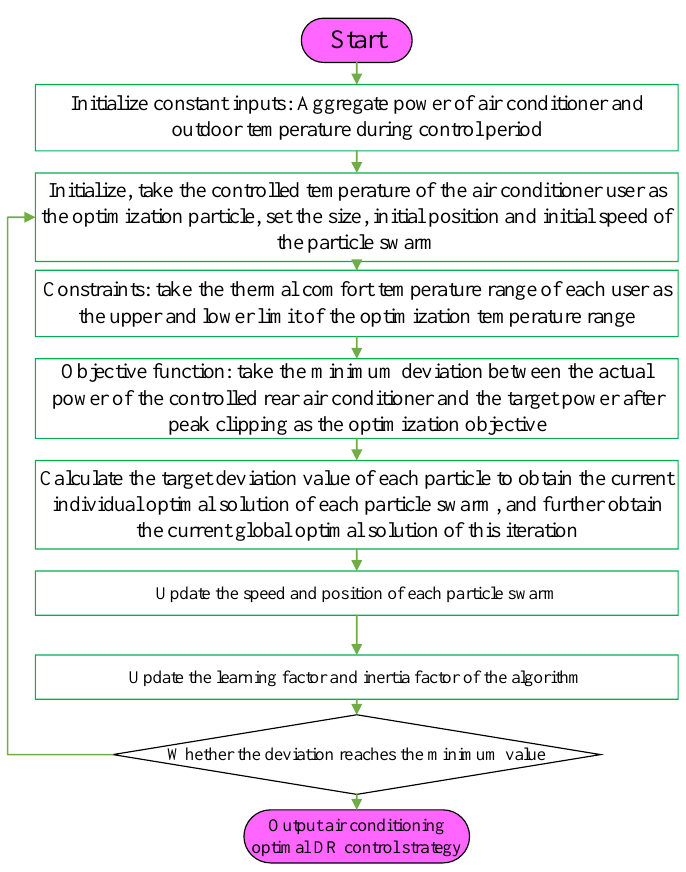
Figure 5. Flow chart of the improved PSO algorithm.